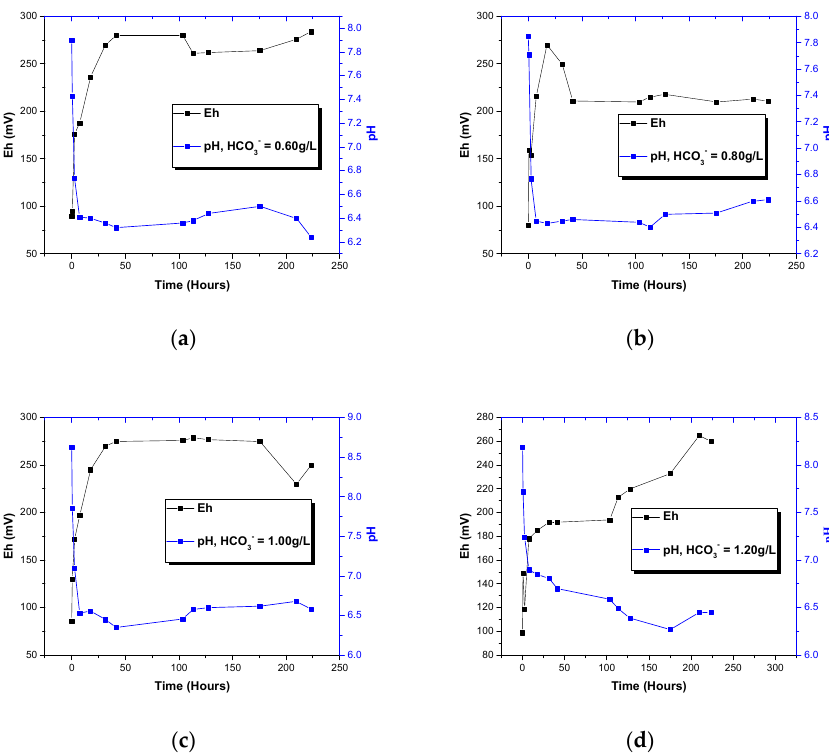
Figure 8. Trend of Eh and pH in leaching solution with different HCO 3 − concentrations: ( a ) 0.60g/L; ( b ) 0.80g/L; ( c ) 1.00g/L; ( d ) 1.20g/L.